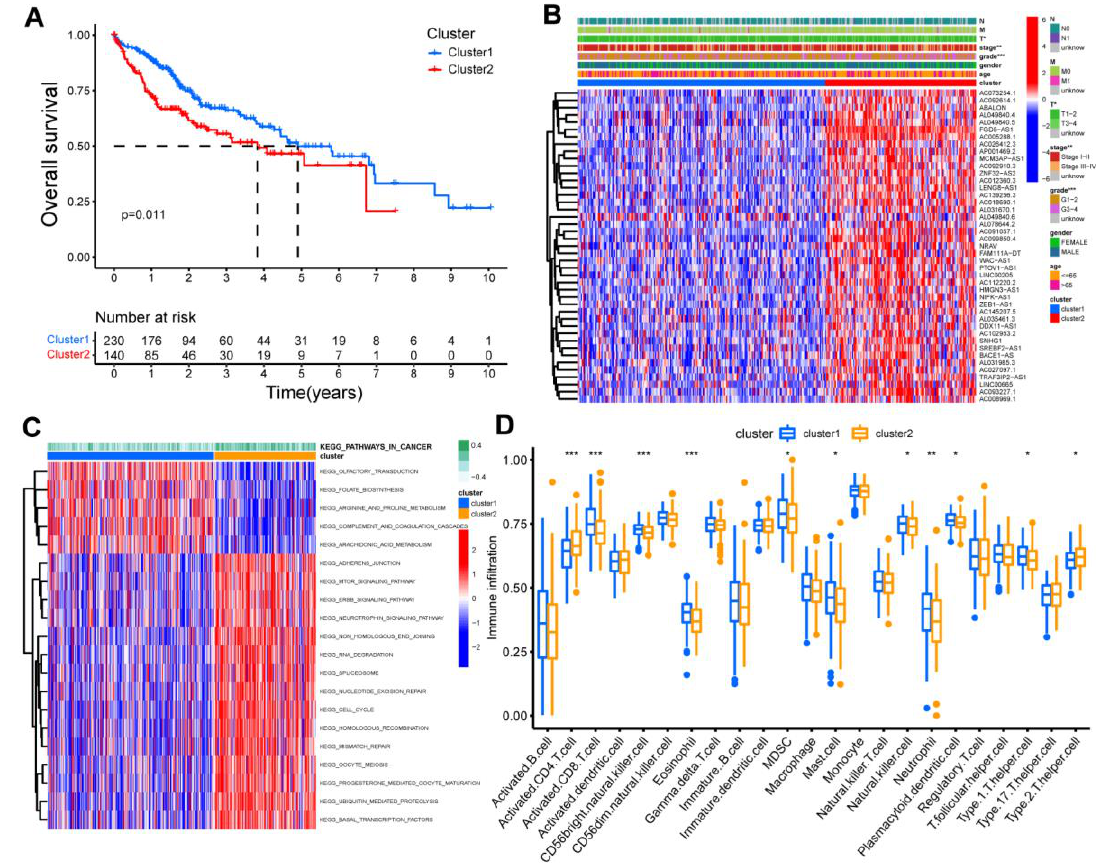
Figure 2. Clinical prognostic values and functions of two clusters based on the m1A-related lncRNAs. ( A ) Kaplan–Meier curve of overall survival between cluster 1 and cluster 2. ( B ) Expression pattern and clinical characteristics of cluster 1 and 2. ( C ) Identification of key pathways by GSVA analysis in both clusters. ( D ) Differential expression levels of 23 immune cells between cluster 1 and 2. *, p < 0.05; **, p < 0.01; ***, p < 0.001. Gene set enrichment analysis, GSEA.